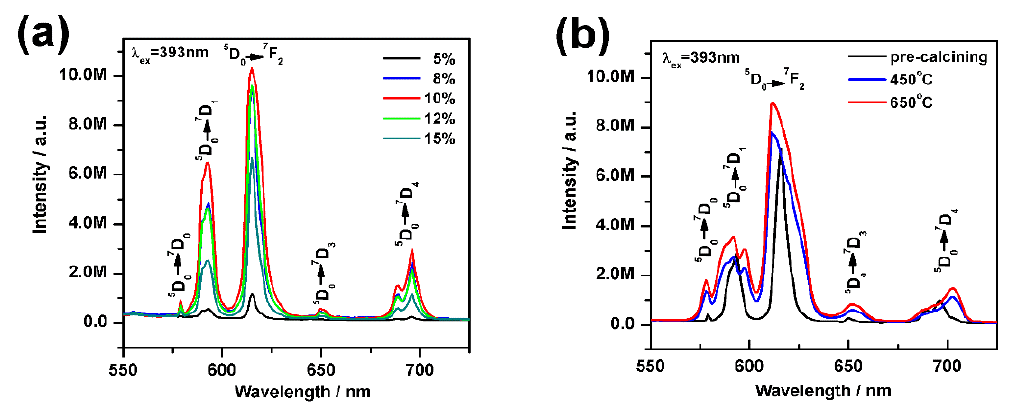
Figure 7. PL emission spectra of Eu 3+ -doped SiO 2 samples (excitation wavelength is 393 nm) pre- pared at 25 °C with ( a ) different doping contents of Eu 3+ and ( b ) different calcination